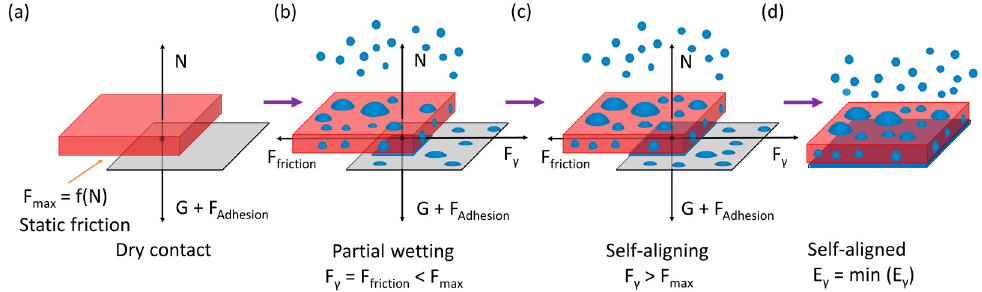
Figure 4. Schematic and force configuration of mist capillary self-alignment process: ( a ) a chip is placed on the top of a receptor site and dry contact forms in between; ( b ) mist induced droplets are delivered onto the assembly site and partially wet the gap between the chip and receptor site; ( c ) droplets wet the whole gap and overcome the static friction force while driving the chip to self-align with the receptor site; and ( d ) the surface energy of the meniscus in the gap is minimized and the chip is aligned with the receptor site.